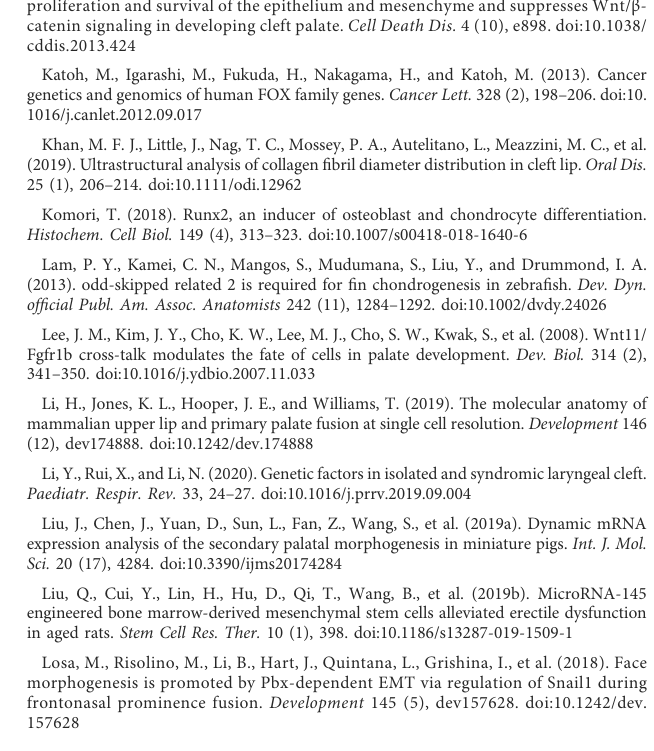
SUPPLEMENTARY TABLE S4 Upregulated and downregulated DEGs for Venn diagrams. SUPPLEMENTARY TABLE S5 KEGG terms used for GSEA analysis. SUPPLEMENTARY TABLE S6 Signal pathways and relative genes used for the construction of signal-gene network. SUPPLEMENTARY TABLE S7 Detailed information on alternative splicing